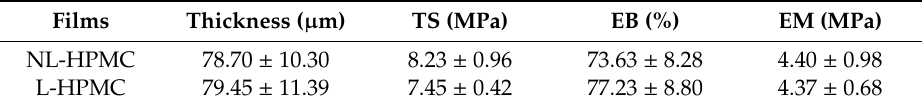
Table 3. Parameters of mechanical properties for nonloaded (NL-HPMC) and loaded (L-HPMC) mucoadhesive films. Values are presented as mean ± standard deviation ( n = 4).